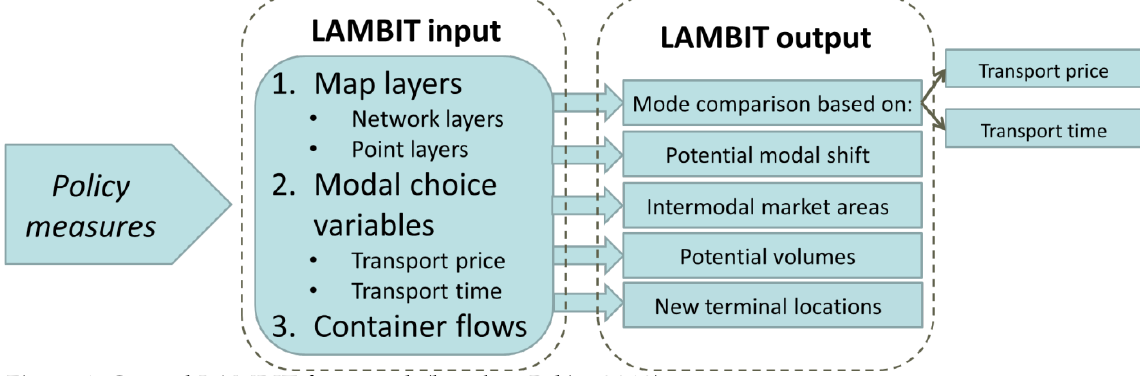
Figure 1. General LAMBIT framework (based on Pekin, 2010) Data